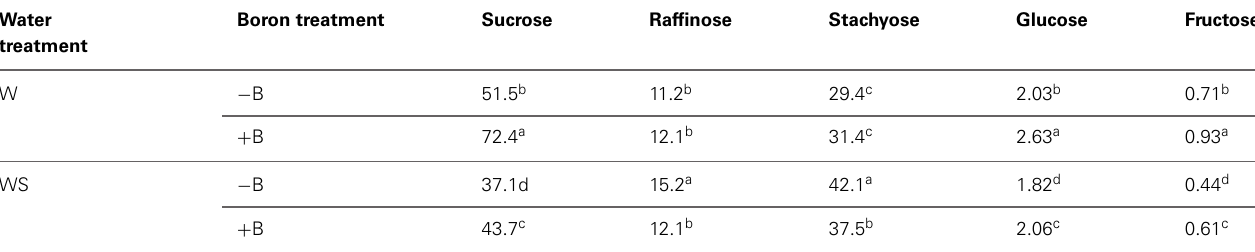
Water treatment